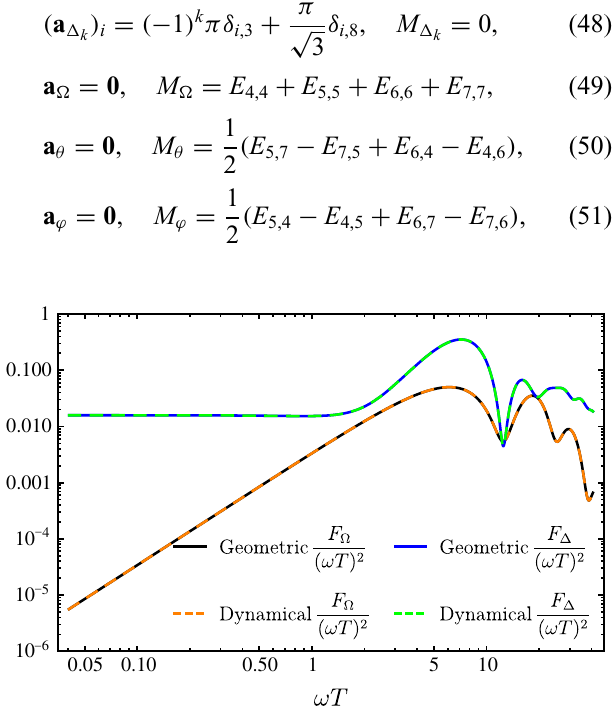
FIG. 9. A comparison of the geometric and dynamical T - gate filter functions for additive dephasing and multiplicative amplitude noise when (cid:11) max = 1. We verify that the two control Hamiltonians produce the same filter